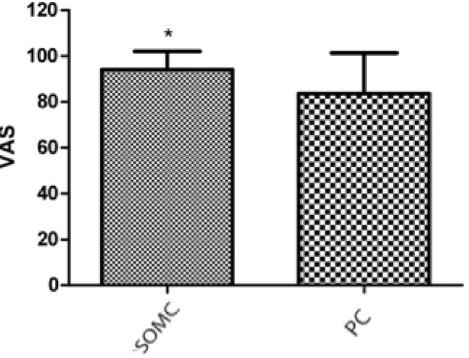
Figure 5. Graph of the Visual Analog Scale (VAS), in points, of patients who underwent cerebral aneurysm microsurgery, evaluated as outpatients. Supraorbital minicraniotomy (SOMC) and pterional craniotomy (PC) were used. The bars represent the average ± standard deviation of SOMC (n = 17) and PC (n = 14) accesses in patients who underwent aneurysm surgery (*p < 0.036: unpaired Student’s t